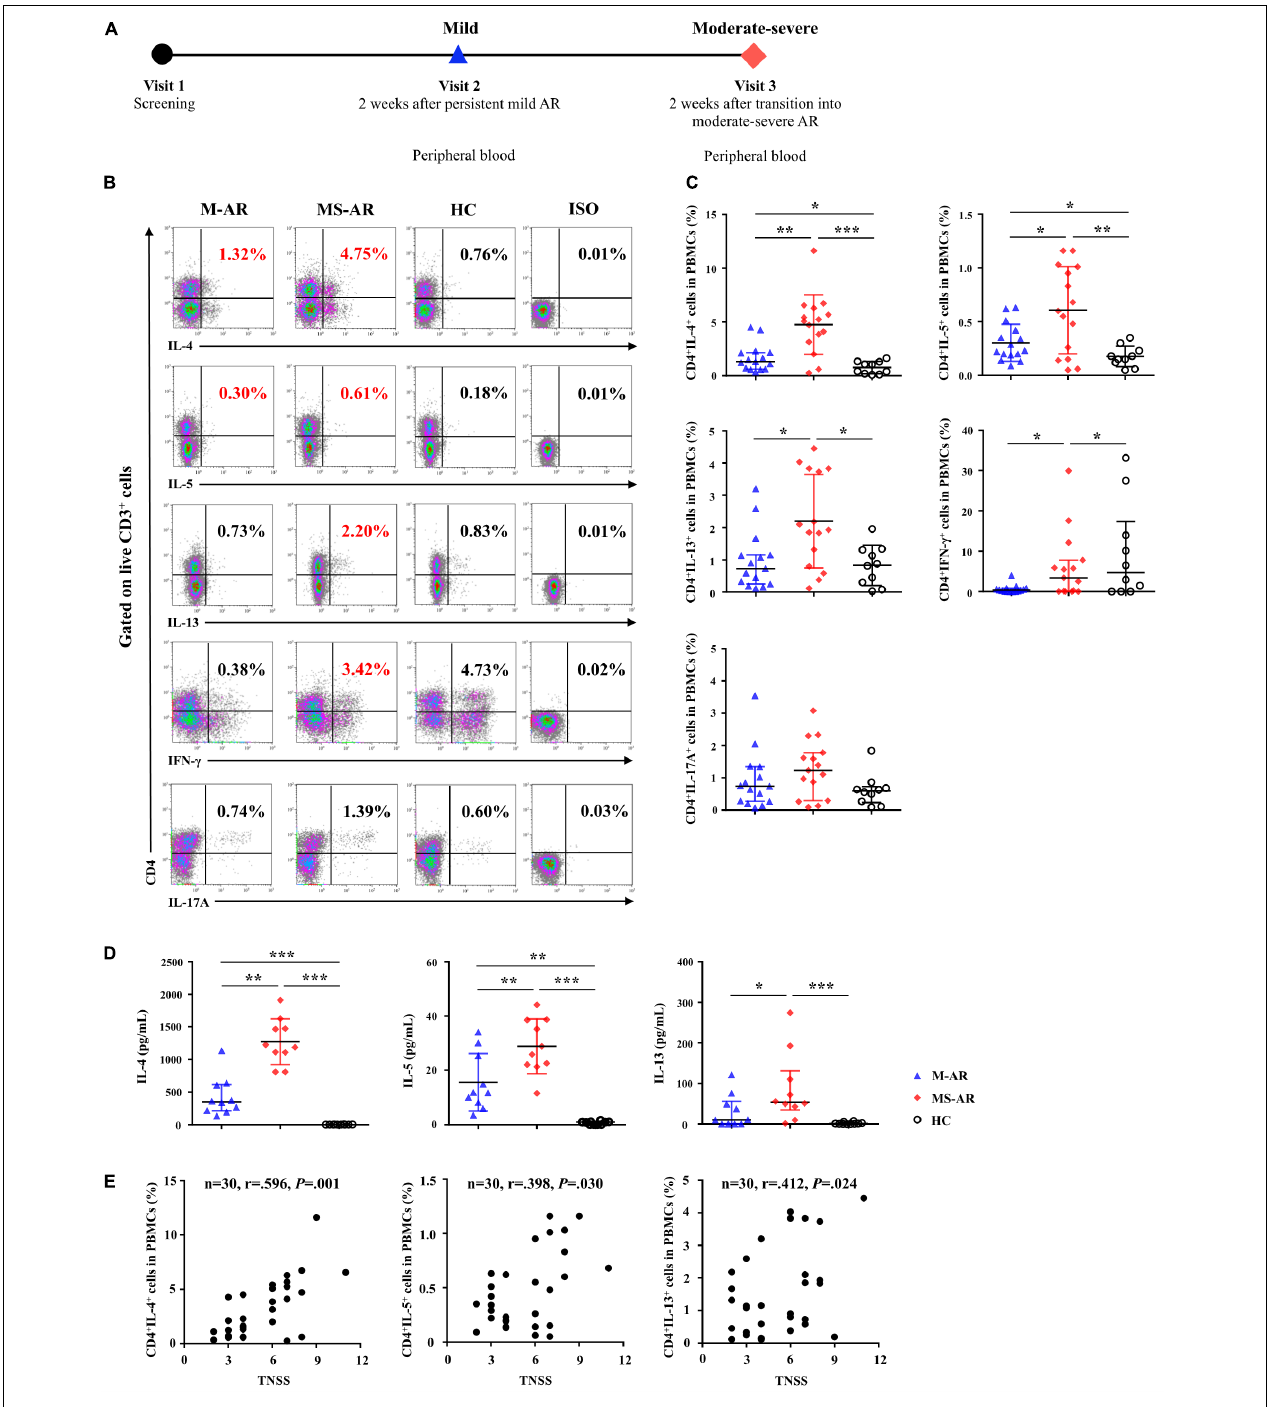
FIGURE 8 | Enhanced Th2 response, but not IL-25, IL-33, and TSLP levels, was associated with disease exacerbation in AR patients. (A) Flow diagram for follow-up study of AR patients. (B) Representative flow plots of IL-4, IL-5, IL-13, IFN- γ , and IL-17 expression by CD4 + T cells in PBMCs from AR subjects in both mild phase (M-AR) ( n = 15) and moderate to severe phase (MS-AR) ( n = 15), and HC ( n = 10) subjects. (C) Quantification of percentages of IL-4 + , IL-5 + , IL-13 + , IFN- γ + , and IL-17 + cells in CD4 + T cells in PBMCs. (D) Protein levels of IL-4, IL-5, and IL-13 in serum of AR ( n = 15) and HC ( n = 10) subjects, as measured by ELISA. Data were tested for normality using the Shapiro–Wilk test, and expressed as means ± SD or medians with interquartile range (IQR), according to normality test results. Significant differences were tested using Student’s t -test or the Mann–Whitney U test between HC and AR groups, and using the paired t -test or Wilcoxon matched pairs signed rank test between M-AR and MS-AR groups. (E) Correlation of Total Nasal Symptom Score (TNSS) with percentage of IL-4 + , IL-5 + , and IL-13 + T cells in PBMCs among M-AR and MS-AR patients ( n = 30) were analyzed using Spearman’s rank correlation coefficient ( r = 0.596, P = 0.001, 1– β = 0.952; r = 0.398, P = 0.030, 1– β = 0.604; and r = 0.412, P = 0.024, 1– β = 0.638, respectively). * P < 0.05, ** P < 0.01, *** P < 0.001.